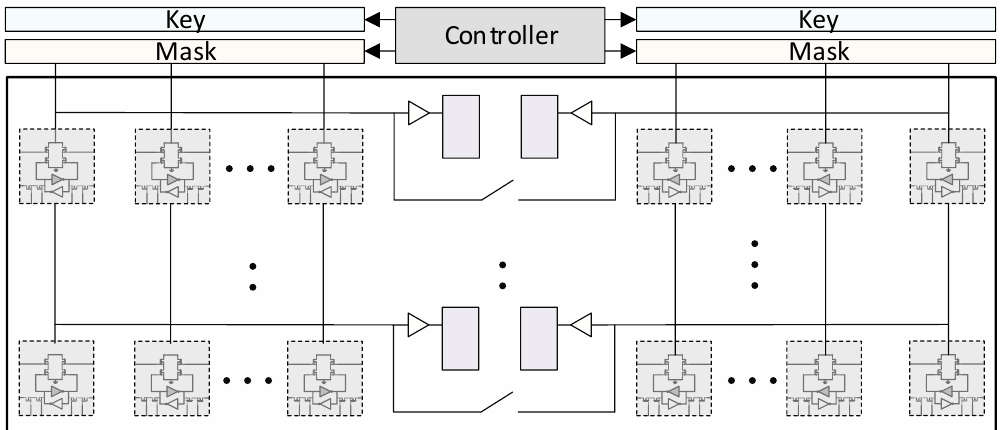
Figure 8. Dual-issue FFT on the